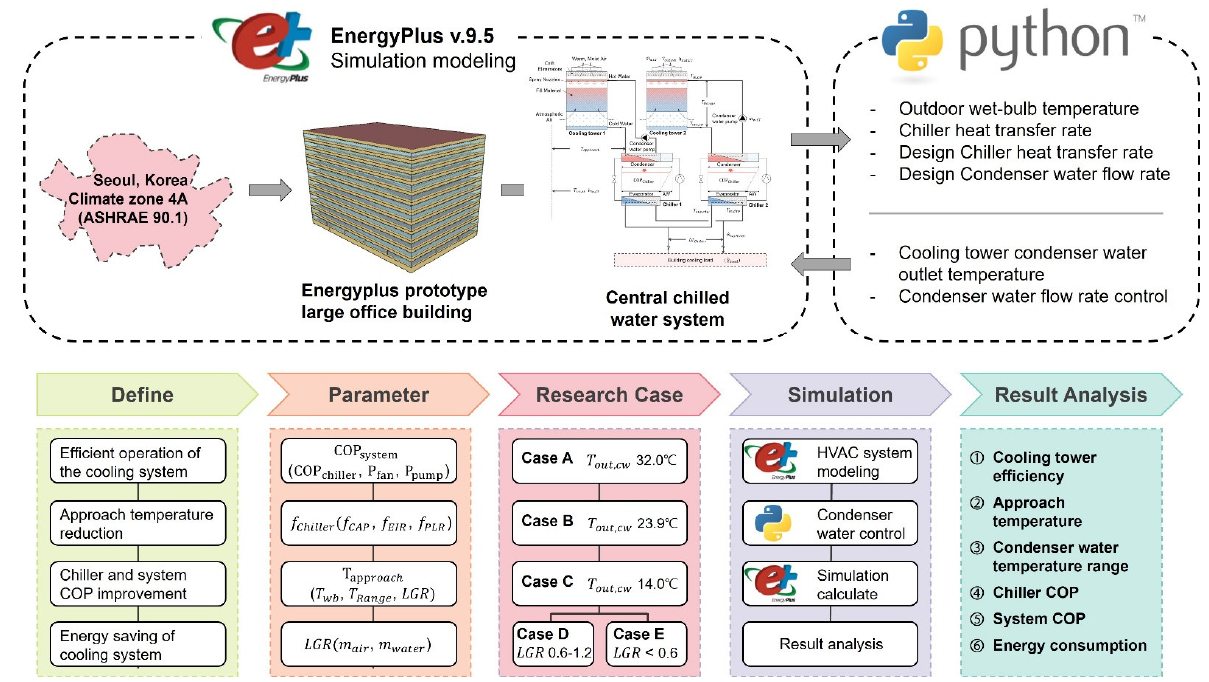
Figure 3. Study flow chart.